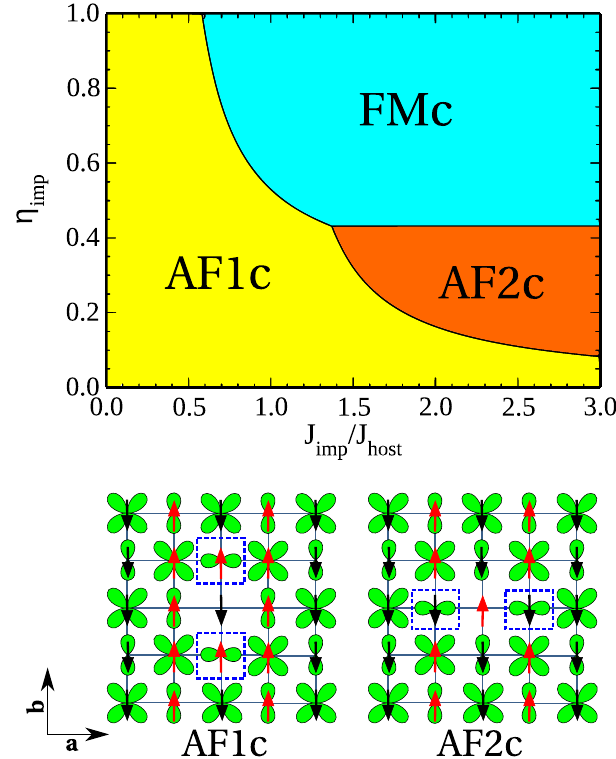
FIG. 8. Top: Phase diagram of the 3 d impurity in the 4 d host with C -AF or G -AO order and the impurity doped at the c -doublon sublattice. Different colors refer to local spin order around the impurity: AF c 1 , AF c 2 , and FM. Bottom: Schematic view of spin-orbital patterns for the two AF ground-state configurations shown in the top panel; the FM c phase differs from the AF c 2 one only by spin inversion at the 3 d atom. The 3 d atom is at the central site and has no doublon orbital; the frames highlight the spin-orbital defects caused by the impurity. As in Fig. 6, the labels AF and FM refer to the impurity-spin orientation with respect to the neighboring 4 d